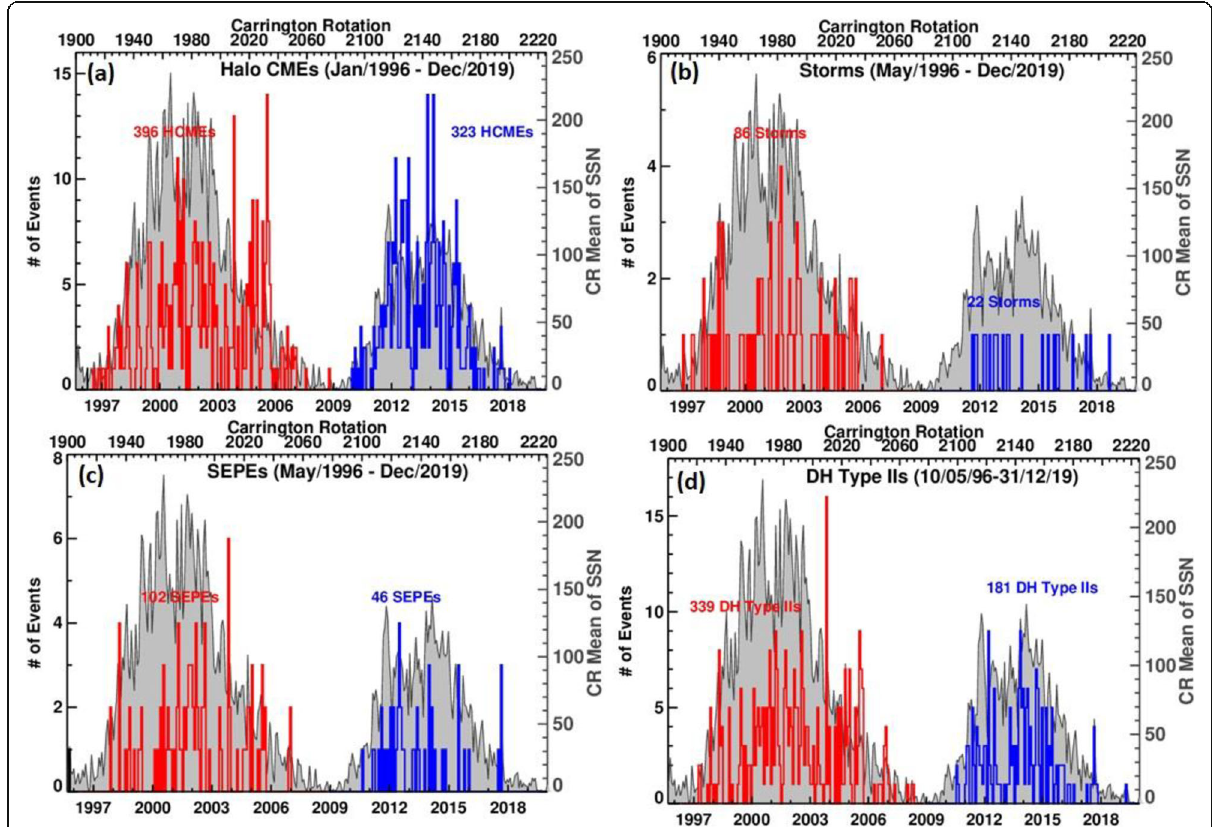
Fig. 6 Solar cycle variation of the key CME-related phenomena during cycles 23 and 24 (from 1996 to the end of 2019): a SOHO/LASCO halo CME number from https://cdaw.gsfc.nasa.gov/CME_list/halo/halo.html. b the number of large geomagnetic storms (Dst ≤ − 100 nT), c the number of large solar energetic particle events (SEPEs) detected in the > 10 MeV GOES channel with intensity exceeding 10 pfu, and d the number of decameter-hectometric (DH) type II radio bursts from Wind/WAVES. For comparison with the solar cycle, the sunspot number averaged over Carrington rotation (CR) periods is also shown. Updated from Gopalswamy et al. (2015a, b,